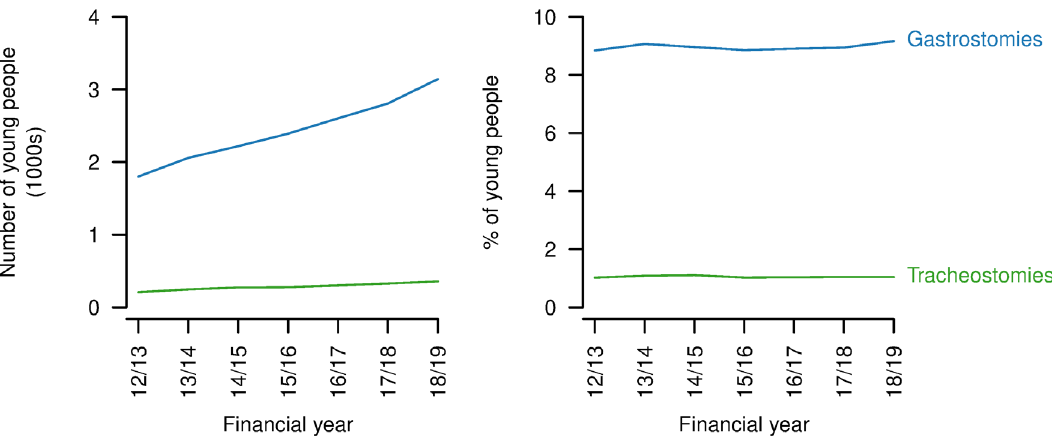
Figure 9. Technology dependence for young people aged 14–19 years with a life-limiting condition. Numbers (left) and proportions (right) of young people aged 14–9 years with a life-limiting condition also having a gastrostomy or tracheostomy present in each year.